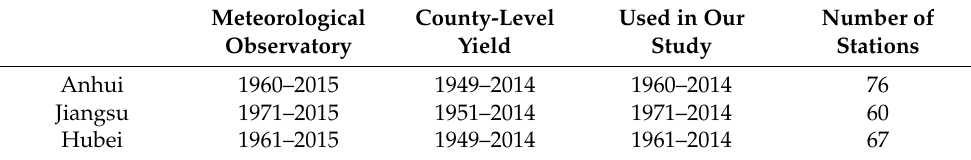
Table 1. Specific period information of meteorological observations and county-level